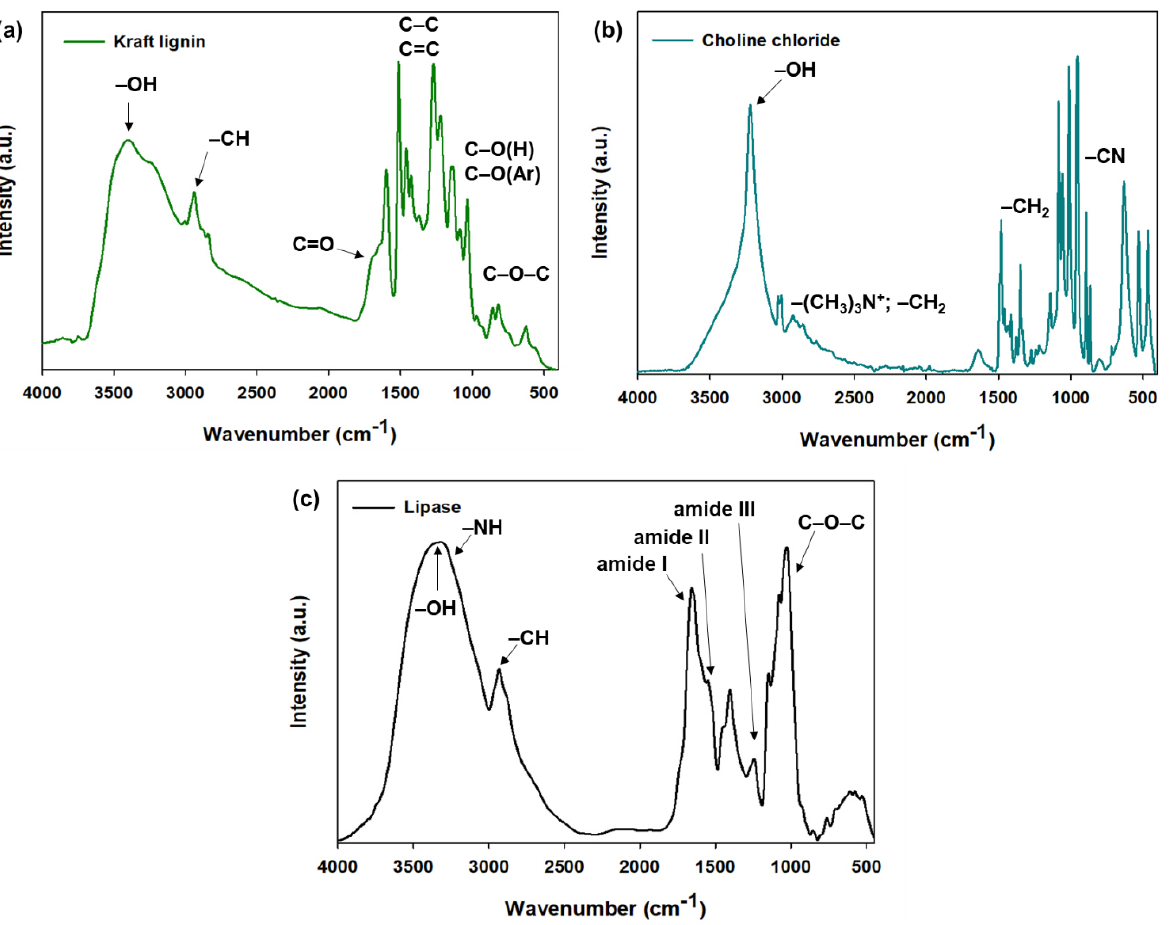
Figure 2. ATR – FTIR spectra of ( a ) kraft lignin, ( b ) choline chloride, and ( c ) Candida antarctica lipase